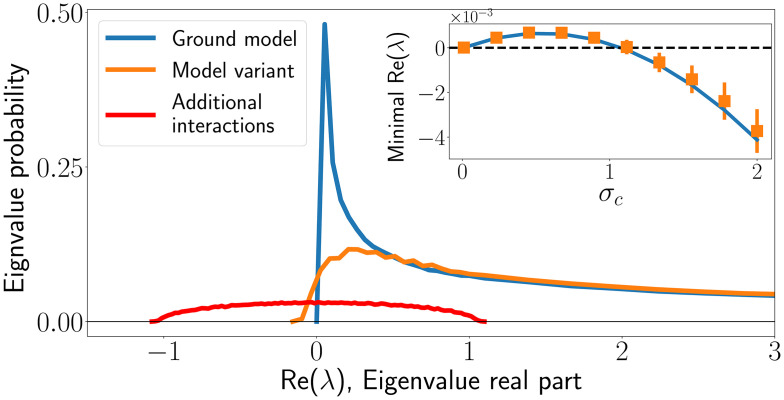
Spectrum of α*, the interaction matrix of persistent species, in the ground model (blue), and the variant with additional direct interactions (orange).The perturbation spectrum is shown in red, to illustrate its size we normalize the area under the perturbation spectrum to the size of the relative perturbation strength (0.05). (Inset) Minimal eigenvalue real part of the reduced interaction matrix α*, when varying σc at fixed μc. Solid line is theoretical curve. A phase transition occurs when the minimal real part of the eigenvalues crosses λmin = 0, from λmin > 0 at which fixed points of the dynamical system are stable, to λmin < 0 where all fixed points are unstable and persistent dynamics ensue. For example, here the transition happens at σc close to 1.